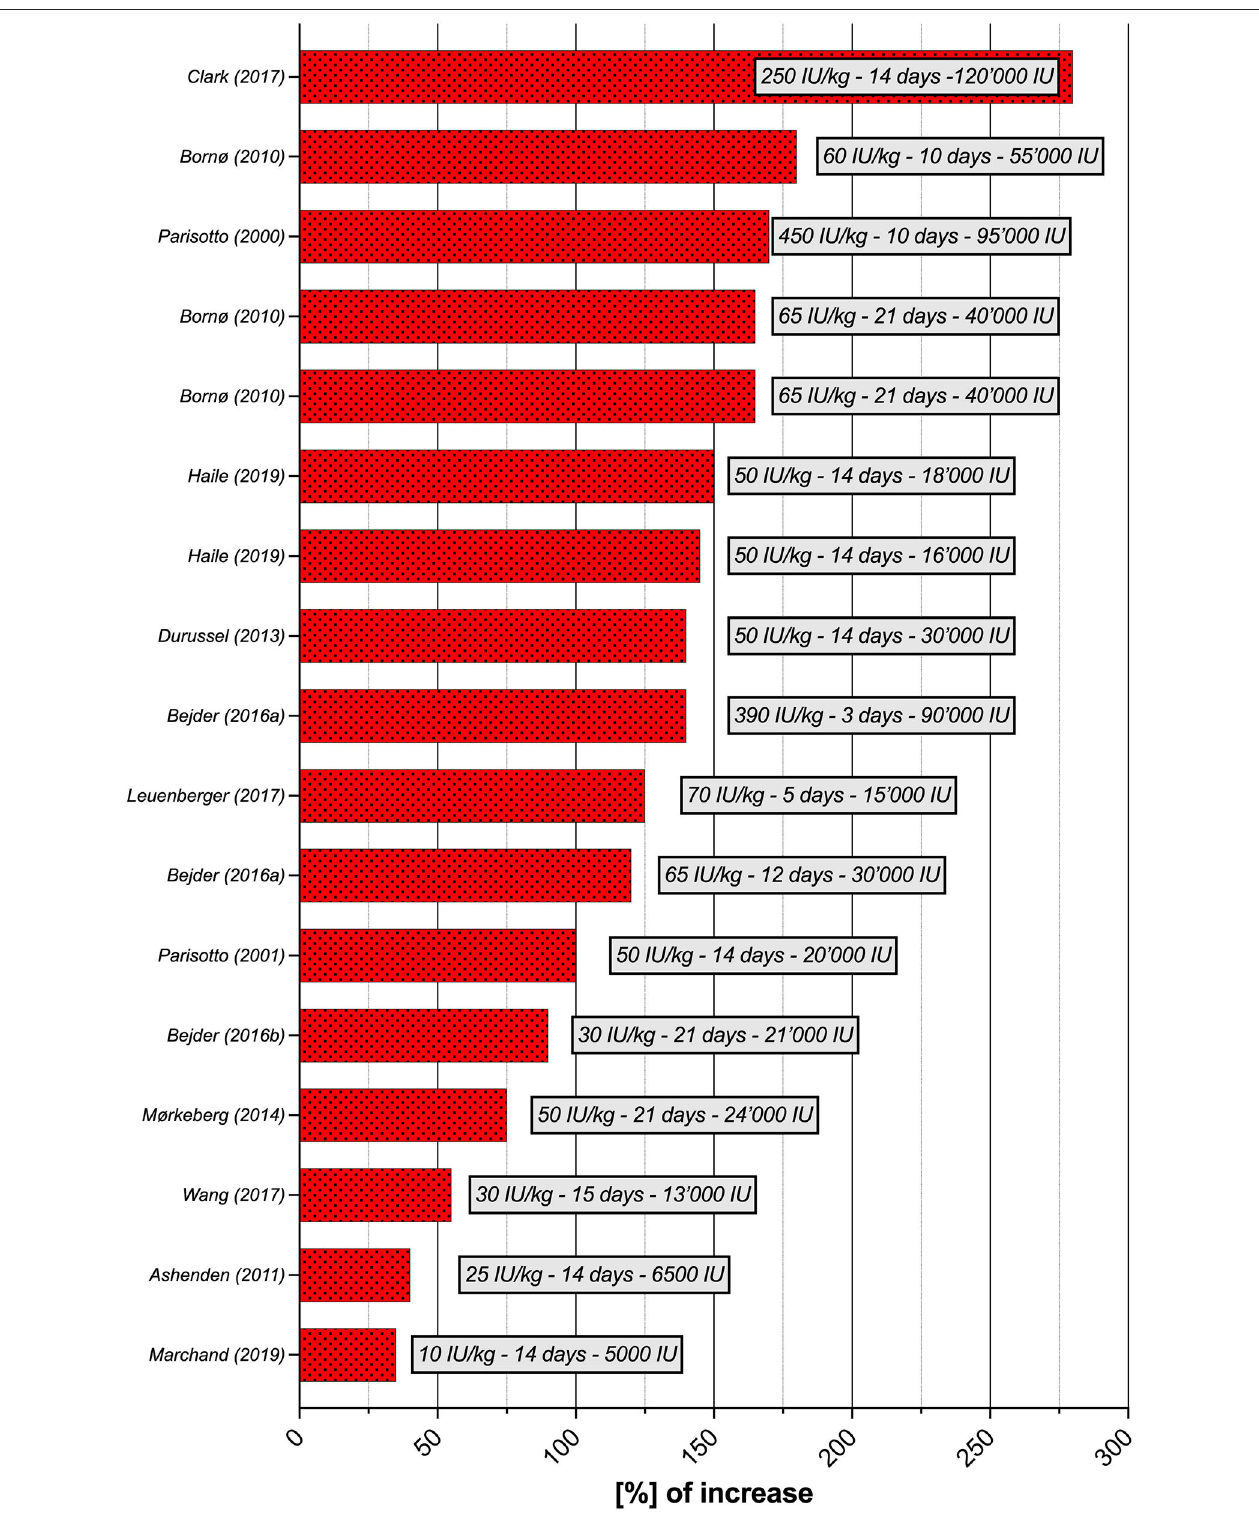
FIGURE 3 | Increase in [%] of RET% per study ( n RET%, reticulocyte percentage.